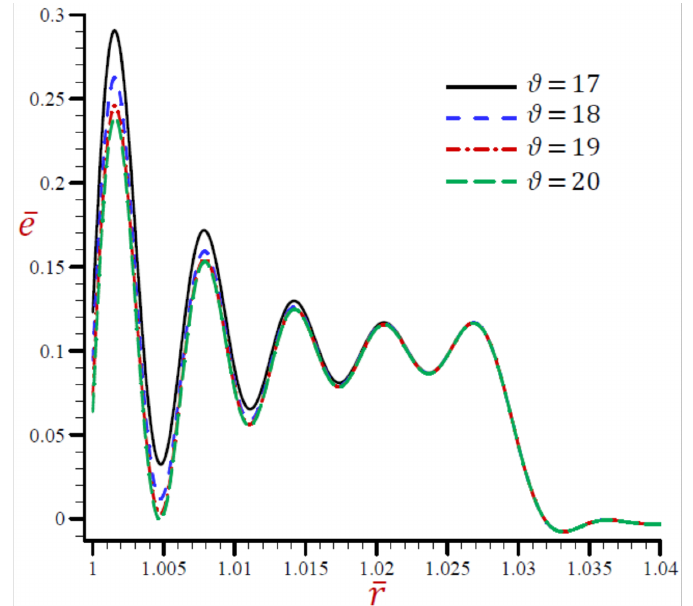
Figure 14. Effect of ϑ on dilatation e across the radial direction of the cylindrical cavity utilizing the RDPL model.